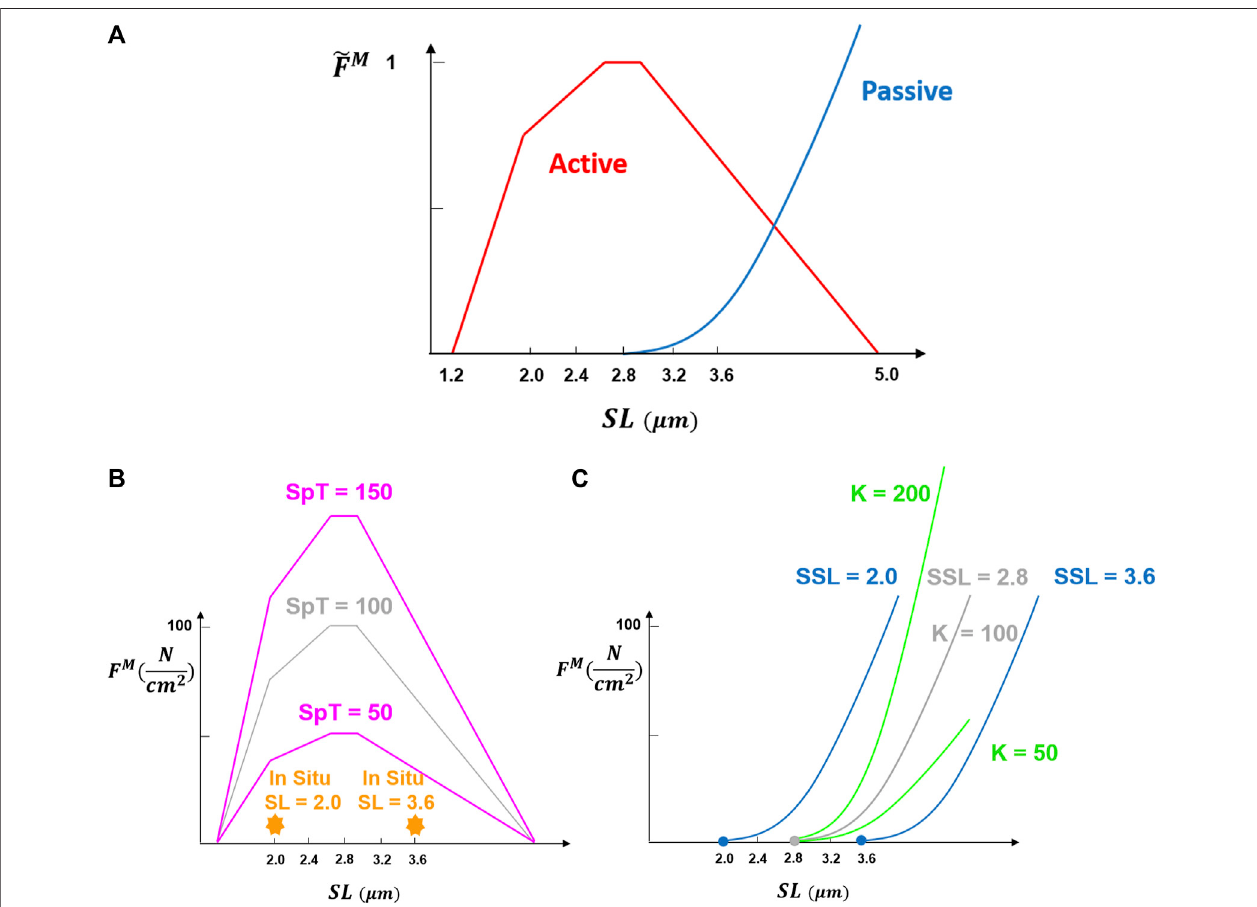
FIGURE1| Fundamentalmuscleforce-lengthcurvewasadoptedfromMillardetal.(2013).Normalizedmuscleforce ~ F M isequalto1atoptimumsarcomerelength whichisassumedtobe2.8 μ minhumans.Multiplying ~ F M bythespeci fi ctensiongivesthemaximumforceperunitareaamusclecanproducewhenfullyactivatedwhich dependsonthesarcomerelength[graph (A) ].Thenonnormalizedforce-lengthcurvesmaynotbethesameforallmusclesorindividuals,andthegeneratedforcescould vary with regard to certain parameters including [graph (B) ] posture-speci fi c in situ sarcomere length (SL) and the speci fi c tension (SpT) or [graph (C) ] slack sarcomere length (SSL) and stiffness scaling factor (K). Note that fi ve different values were considered and tested for each parameter in this study but only two or three representative values for each parameter are shown in this fi gure. The gray color refers to the values used for the baseline model.